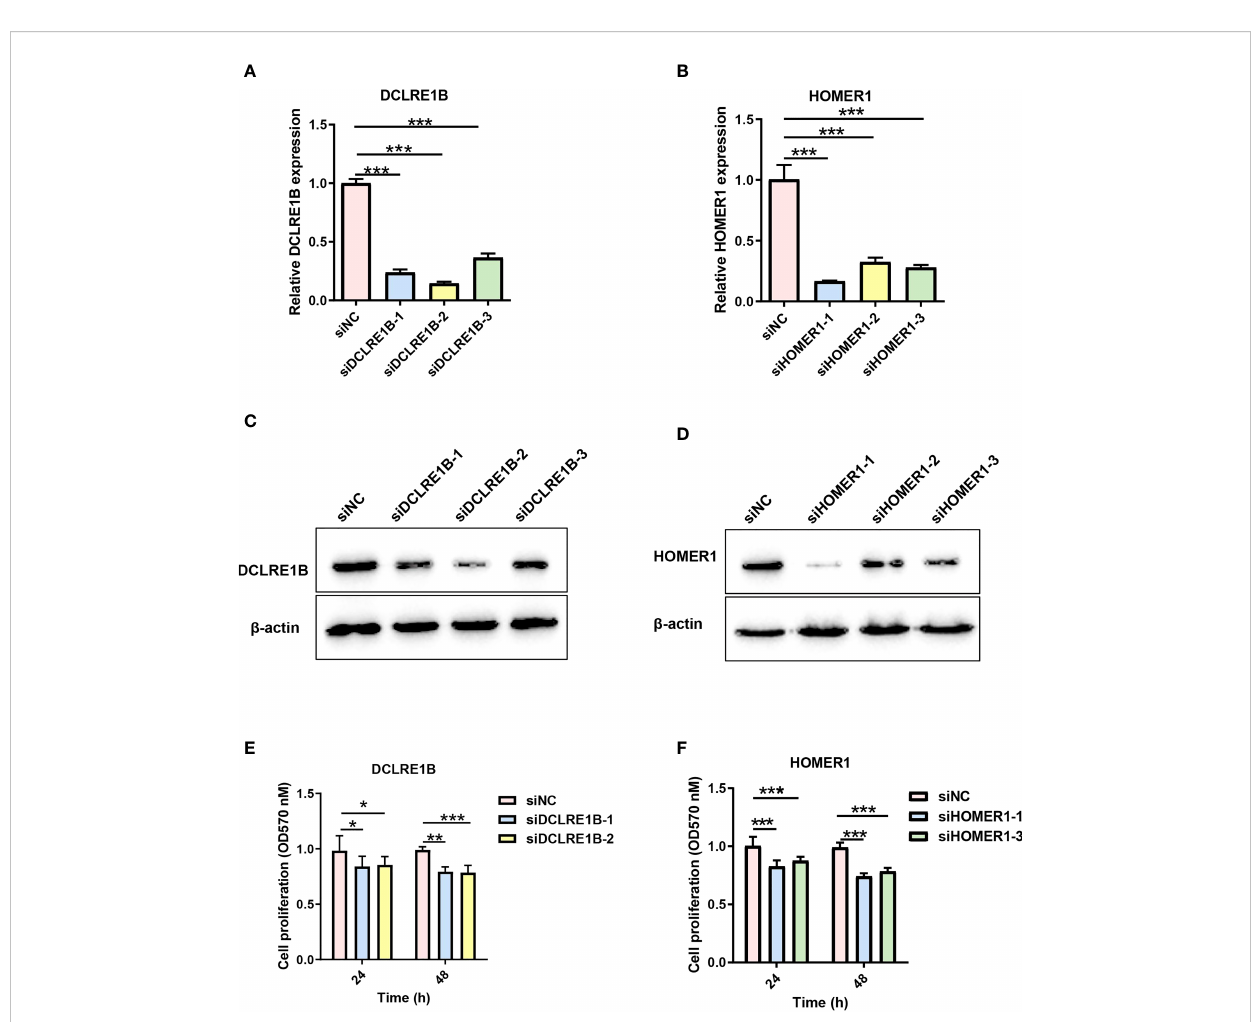
FIGURE 13 Validation of cell proliferation for DCLRE1B and HOMER1 in LUAD cell line A549. A549 cells were transiently transfected with siRNA (siDCLRE1B-1, siDCLRE1B-2, siDCLRE1B-3, siHOMER1-1, siHOMER1-2 or siHOMER1-3) or with its corresponding negative control (siNC). RT-qPCR (A, B) and western blot (C, D) were used to measure DCLRE1B and HOMER1 expressions. (E, F) MTT assay was used to measure cell proliferation. The data were presented as the mean ± standard deviation. ∗ P < 0.05, ∗∗ P < 0.01 and ∗∗∗ P <